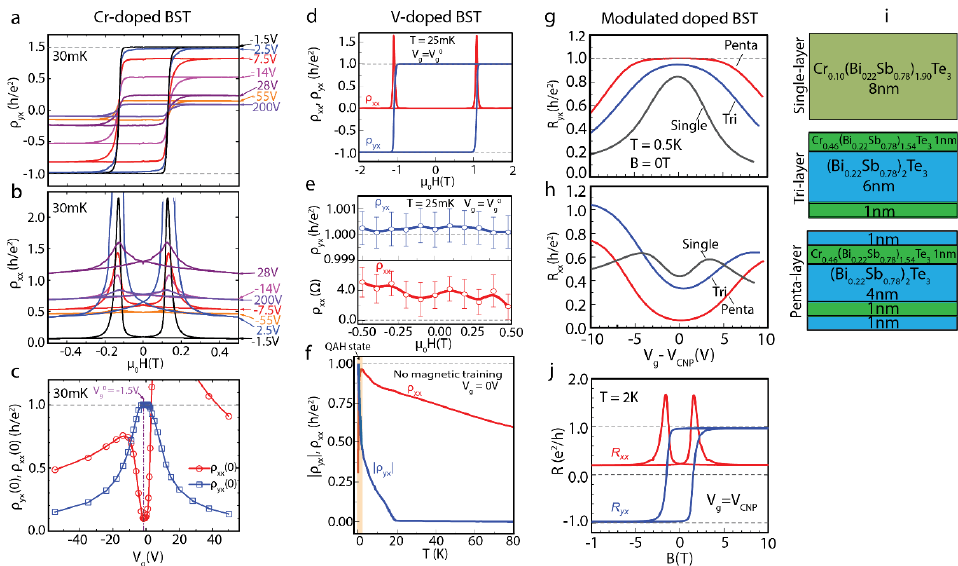
Figure 5: QAHE in MBE-grown magnetic TI films . Magnetic field dependence of a, the Hall resistance ρ and b, the longitudinal sheet resistance ( ρ ) for different yx xx gate voltages ( V ) and at 30 mK in a 5 QL-thick Cr (Bi Sb ) Te film that g 0.15 0.1 0.9 1.85 3 exhibit QAHE. The shape and coercivityof the ρ hysteresis loop remain almost un- yx changed for different V . However, the height of loops changes significantly with g V . ρ is nearly independent of the magnetic field, suggesting perfect ferromagnetic g yx ordering. c, Gate voltage-dependence of ρ and ρ at zero field - labelled ρ (0) yx xx yx (blue squares) and ρ (0) (red circles), respectively. ρ shows a clear quantization xx yx ( h ) and ρ shows a sharp dip down to 0.098 h at the charge neutrality point ( V g0 ), xx e 2 e 2 indicative of QAHE. Figures (a), (b), and (c) are adapted from ref. [ 61 ] d, Mag- netic field dependence of ρ and ρ at the charge neutral point ( V g0 ) in a 4 QL-thick xx yx (Bi Sb ) V Te film that exhibits an enhanced QAHE compared to the Cr- 0.29 0.71 1.89 0.11 3 doped film. e , Expanded view of the magnetic field-dependence of ρ (top panel) yx H | < 0.5 T for the same film. At zero magnetic field, ρ and ρ (bottom panel) at | µ xx yx 0 = 1.00019 ± 0.00069 h and ρ vanishes to 0.00013 ± 0.00007 h . f, ρ (red curve) xx xx e 2 e 2 | (blue curve) as a function of temperature without magnetic training. Fig- and | ρ yx ures (d), (e), and (f) are adapted from ref. [ 62 ] . V dependence of g, ρ and h, ρ of yx xx g modulation magnetic-doped Cr (Bi Sb ) Te structures: single-layer (gray line; x y 1 − y 2 − x 3 schematic shown in i, first panel), tri-layer (blue line; schematic shown in i, second panel), and the penta-layer (red line; schematic shown in i, third panel) at 0.5 K in the absence of external magnetic field. j, Magnetic fielddependence of ρ and ρ for yx xx penta-layer (for the most optimized sample with x = 0.57, y = 0.74) for V g0 at 2 K. Quantized Hall resistance is observed up to 1 K, where the residual ρ is 0.081 h , xx e 2 which is slightly higher than 0.017 h at 0.5 K. At 2 K, ρ shows a reasonable quan- yx e 2 ± 0.87 tization, ± 0.97 h . Then, at 4.2 K, it deviates from perfect quantization ( ρ yx e 2 h ) with a Hall angle of 66.1 ◦ . 2 K is so far the highest temperature at which (al- e 2 beit, approximate) QAH is observed. Figures (g), (h), (i), and (j) are adapted from ref. [ 63